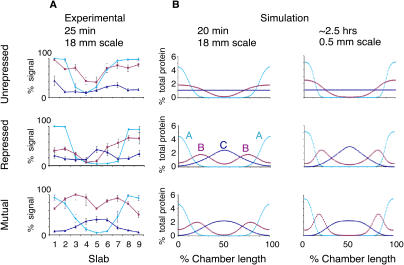
Comparison of Experimental Data and Computer SimulationsData are shown for the three gene networks described in Figure 3, showing outputs for proteins A (cyan), B (magenta) and C (dark blue).(A) Quantitated Western blot data from Figure 3, after 25 min.(B) Simulation data plotted as percentage of total output protein against chamber length, at the chamber (18-mm) or Drosophila (0.5-mm) scale. The model is described in full in Protocol S1.